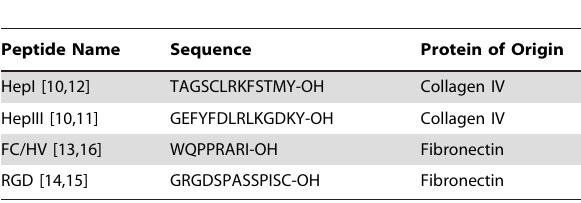
Table 1. Sequence of the peptides along with their source